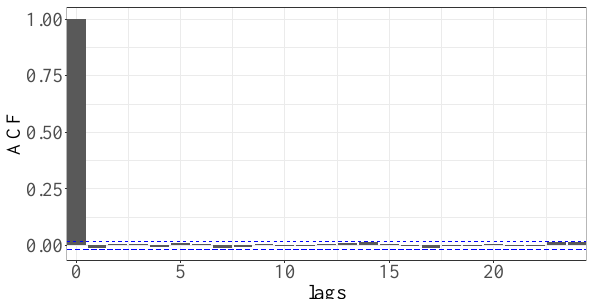
Figure 6. The autocorrelation of the overall residual for GENESE zone. The partial residuals from the estimated smoothers were visually inspected to test